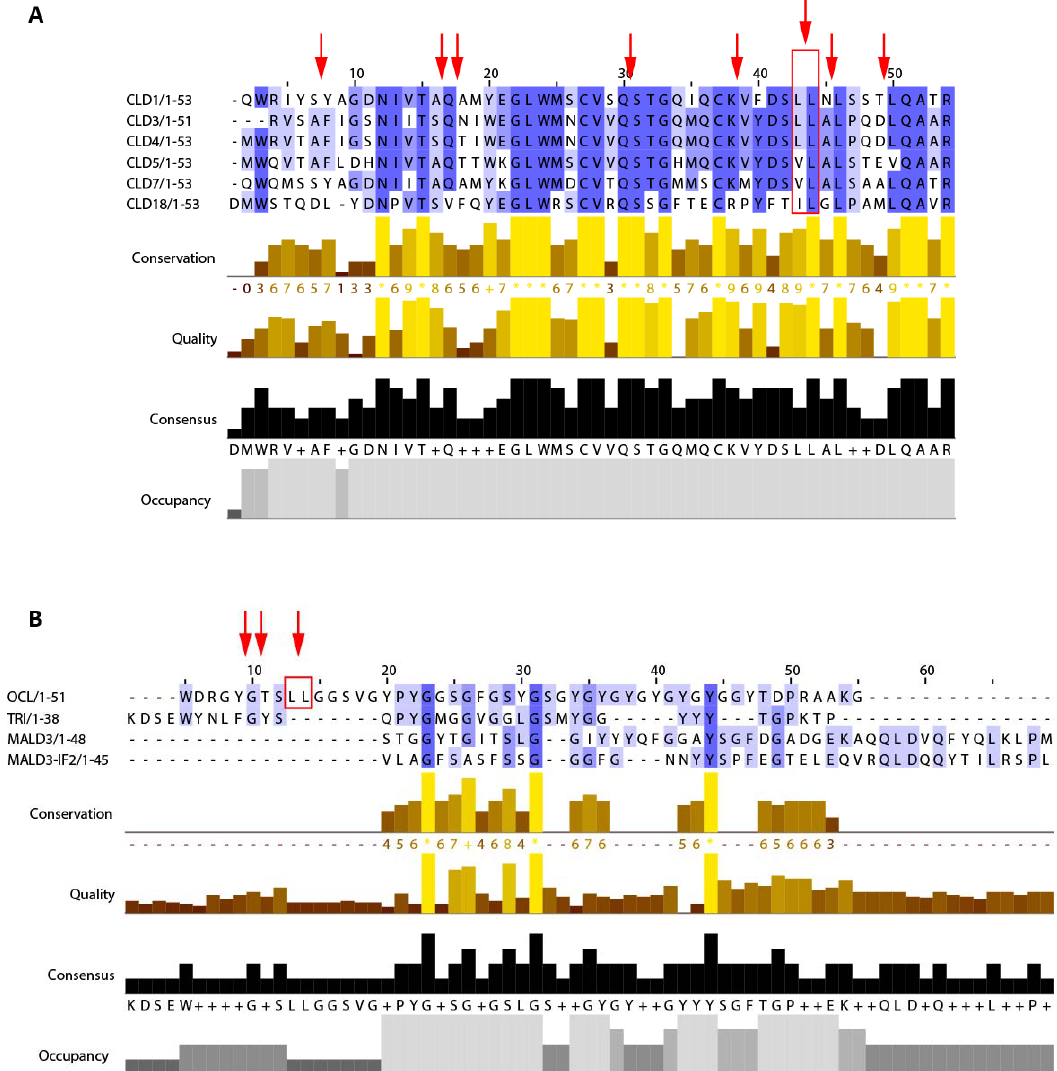
Figure 8. ( A ) Multiple sequence alignments of the first extracellular domain of claudins (CLD) expressed in human lung (claudins 1, 3, 4, 5, 7, and 18) and their consensus sequence created using Clustal Omega and Jalview. Colour shading denotes residues scored for conservation and quality. Arrows denote cleavage sites for Der p 1 identified in this study. ( B ) Sequence alignments of TJ-associated MARVEL domain adhesion proteins (occludin (OCL), tricellulin (TRI), MARVELD3 (MALD3)). Two isoforms of MARVELD3 are shown. Arrows indicate occludin residues cleaved by Der p 1 based on partial scanning of the first extracellular domain [14]. In both panels, the numbers appended after the protein identifier indicate the number of residues in each domain. Dyads bounded by red boxes denote putative cleavage hot spots for Der p 1 and other Group 1 HDM allergens based on the present study and previous work [14].